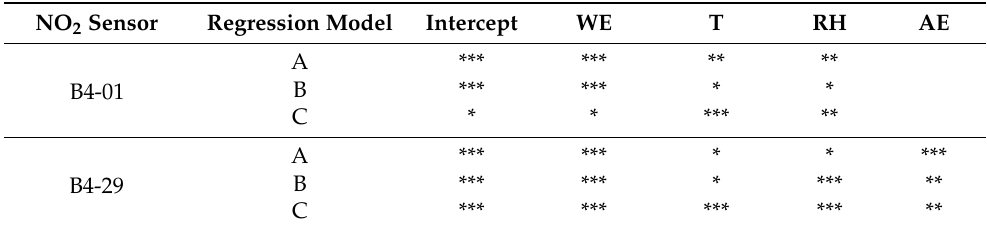
Table 8. Significance levels of the p -values for the variables used in the regression models for the